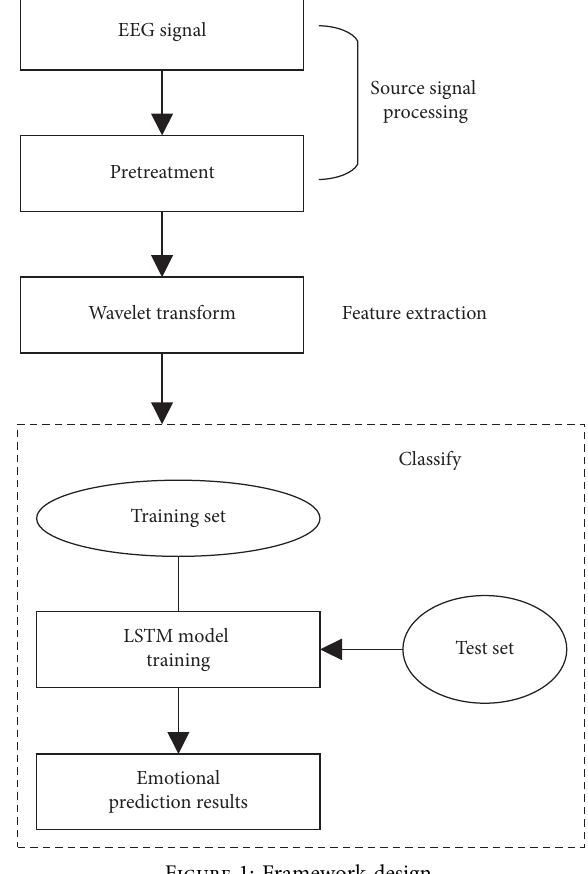
Figure 1: Framework design.